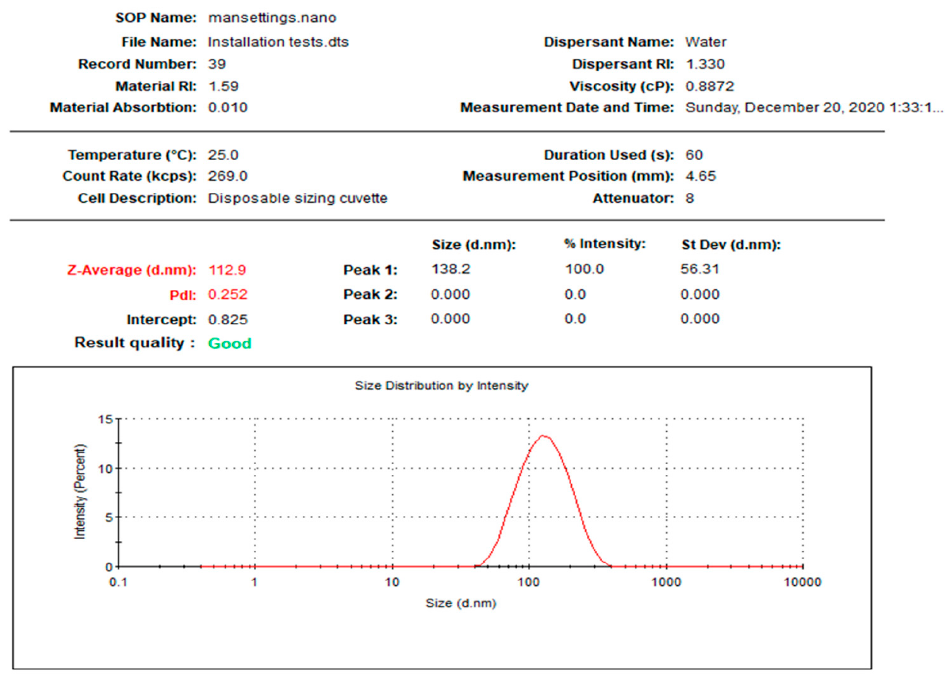
Figure 1. Size distribution of L-AgNPs.